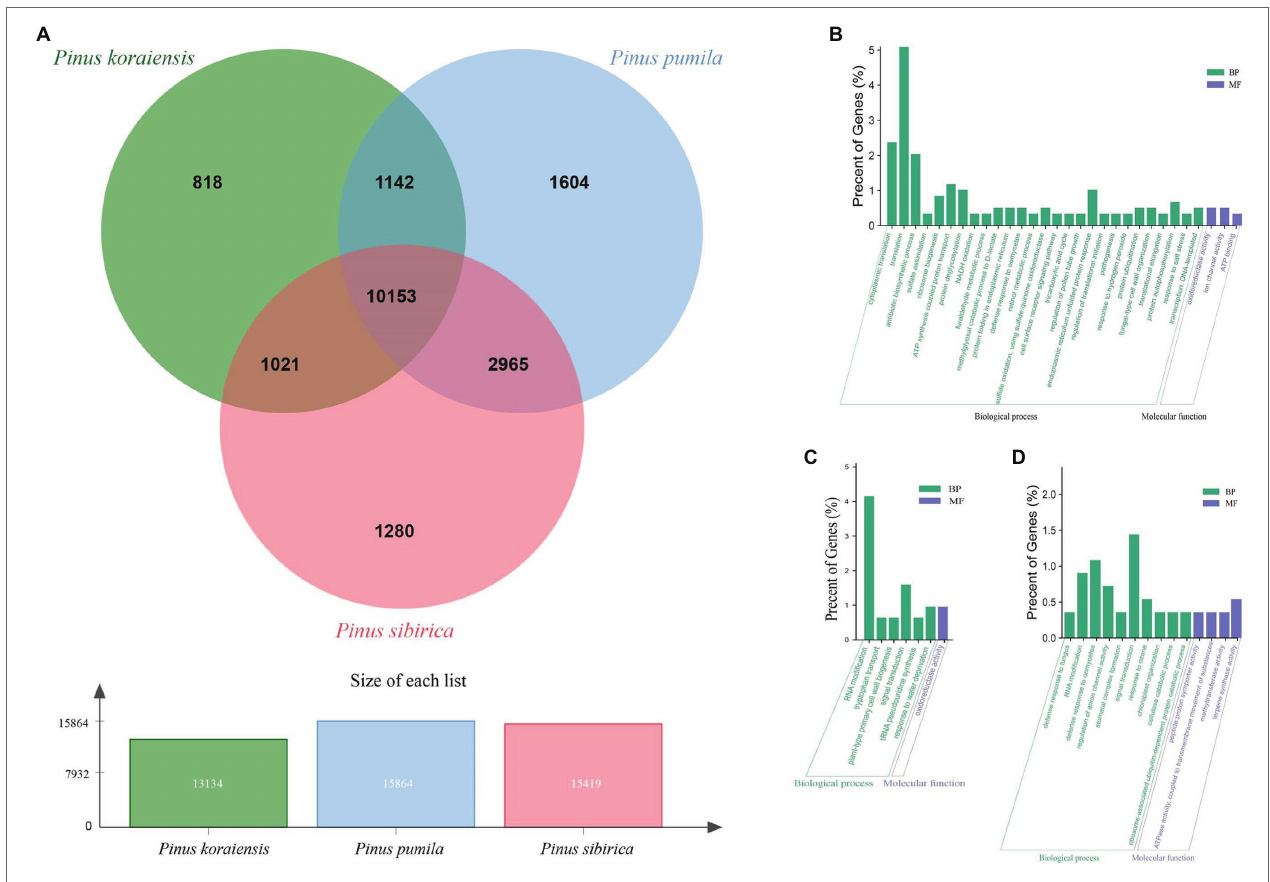
FIGURE 5 | Gene Ontology enrichment analysis of orthologous gene families in the three five-needle pines. (A) Venn diagram depicting the shared and specific gene families in Pinus koraiensis , Pinus sibirica , and Pinus pumila . Orthologous clusters were evaluated for 59,412 concatenated coding sequences (CDS) shared and unique gene families. The counts in the Venn diagram represent the number of unique and shared families between P. koraiensis , P. sibirica , and P. pumila . Around 10,153 gene families were conserved across P. koraiensis , P. pumila , and P. sibirica . GO enrichment analysis of the specific gene families in P. koraiensis (B) , P. sibirica (C) , and P. pumila (D) . The x-axis indicates GO terms belonging to BPs and MFs, and the y-axis represents the percent of genes.